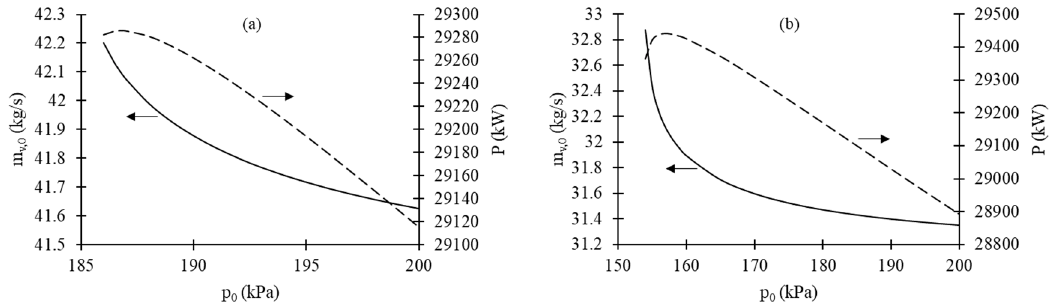
Figure 6. Variations with extracted steam pressure ( p 0 ) of extracted steam consumption ( m v ,0 ) and turbine power output ( P ) of the cogeneration systems that have the optimum distributions of evaporator surface areas for ( a ) the conventional evaporation process and ( b ) the modified evaporation process. Table 1. Simulation results of cogeneration systems for the non-optimum conventional evaporation process, theoptimumconventionalevaporationprocess, andtheoptimummodifiedevaporationprocess. Conventional EP Optimum Modified EP